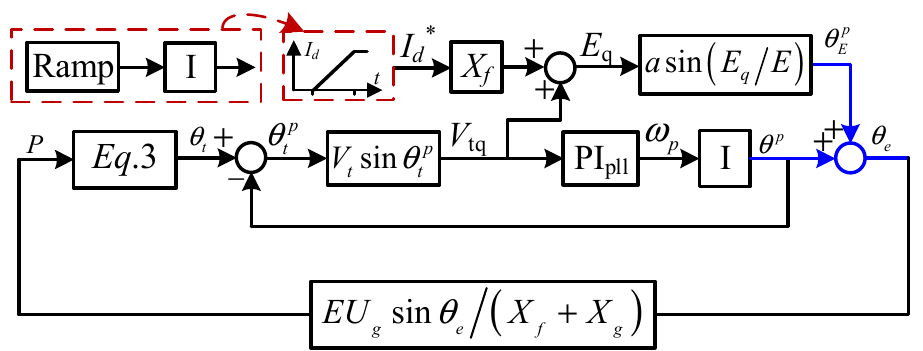
Figure 8. Simplified network topology.